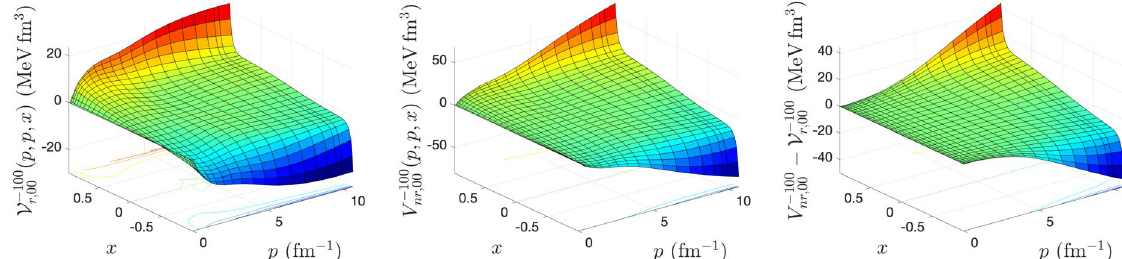
Figure 1. The matrix elements of relativistic NN potential (left panel), nonrelativistic NN potential (middle panel), and their differences (right panel), calculated for CD-Bonn potential in ( s function of 2 N relative momenta p